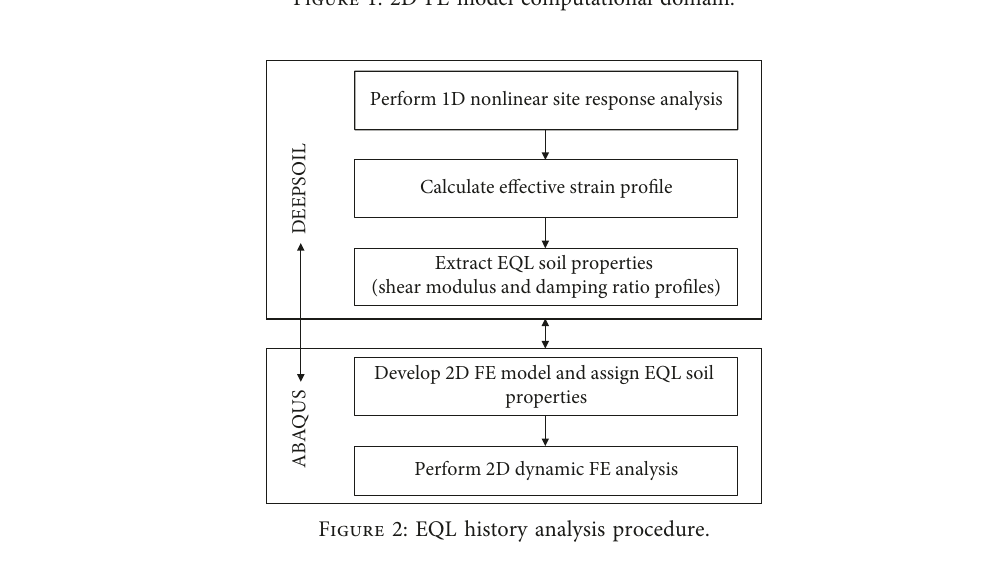
Figure 1: 2D FE model computational domain.